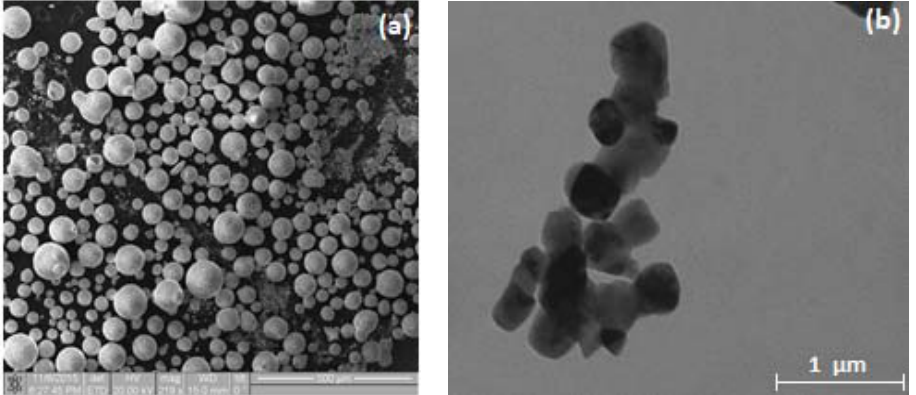
Figure 1. Images of ZrO 2 (3%Y 2 O 3 ) + 20%Al 2 O 3 powders: ( a ) general view of powders and ( b ) image of nanoparticles of which compose the granules.